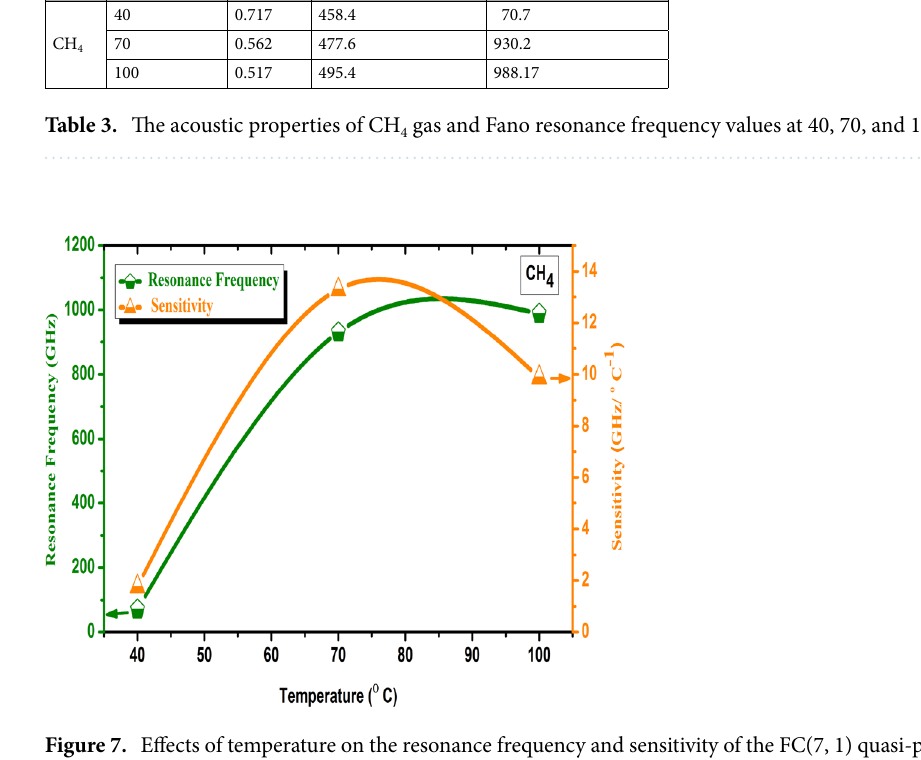
gas. Figure 8 demonstrated the temperature effects on the quality factor and FOM of the 4 FC(7, 1) quasi-periodic gas sensor towards CH 4 gas at 40, 70, and 100 °C. The quality factor introduced the Fano resonance peaks sharpness, the higher the quality factor, the sharper the peak 84 . As observed in Fig. 8, the high- est quality factor and FOM recorded towards CH 4 have values of 7809 and 78.1 (m.s −1 ) −1 respectively at 100 °C, followed by 70 °C with Q and FOM values of 2205 and 31.5 (m.s −1 ) −1 respectively. Thus, the lowest FWHM intro- duced for CH 4 gas at 100 °C with a value of 0.13 GHz followed by 70 °C about 0.42 GHz as represented in Fig. 8.